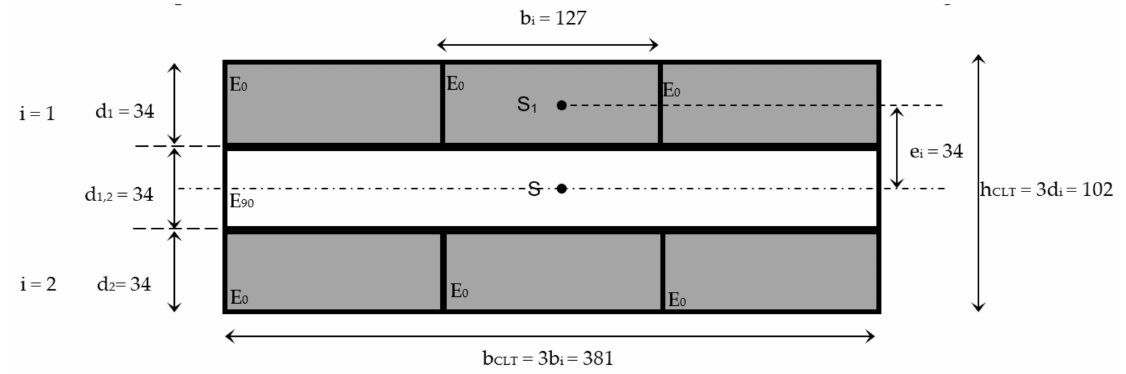
Figure 2. Layout scheme of cross-laminated timber (CLT) (dimensions in